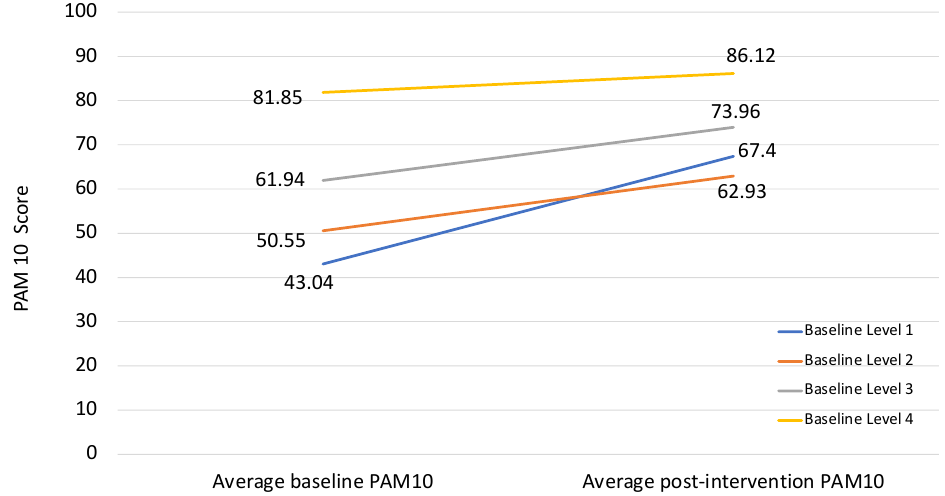
Figure 2. Change in PAM ® 10 scores from average baseline level to post-intervention level for SYDCP remote participants, ( n = 92), San Jose, CA; Lawrence County, MO; Central Valley, CA; 2020 – 21.